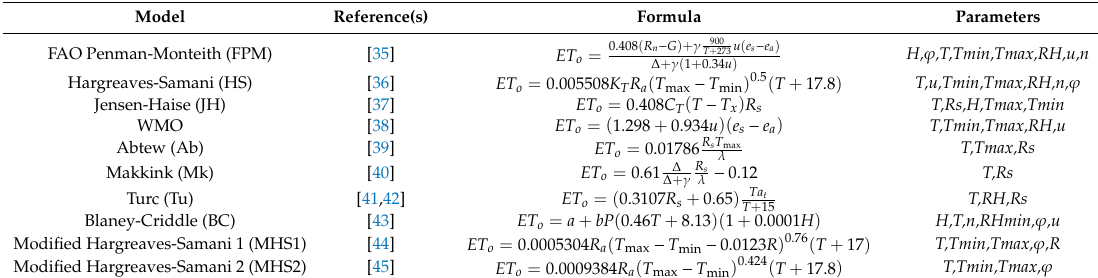
Table 5. Selected models to estimate reference evapotranspiration including their references, formulae, and